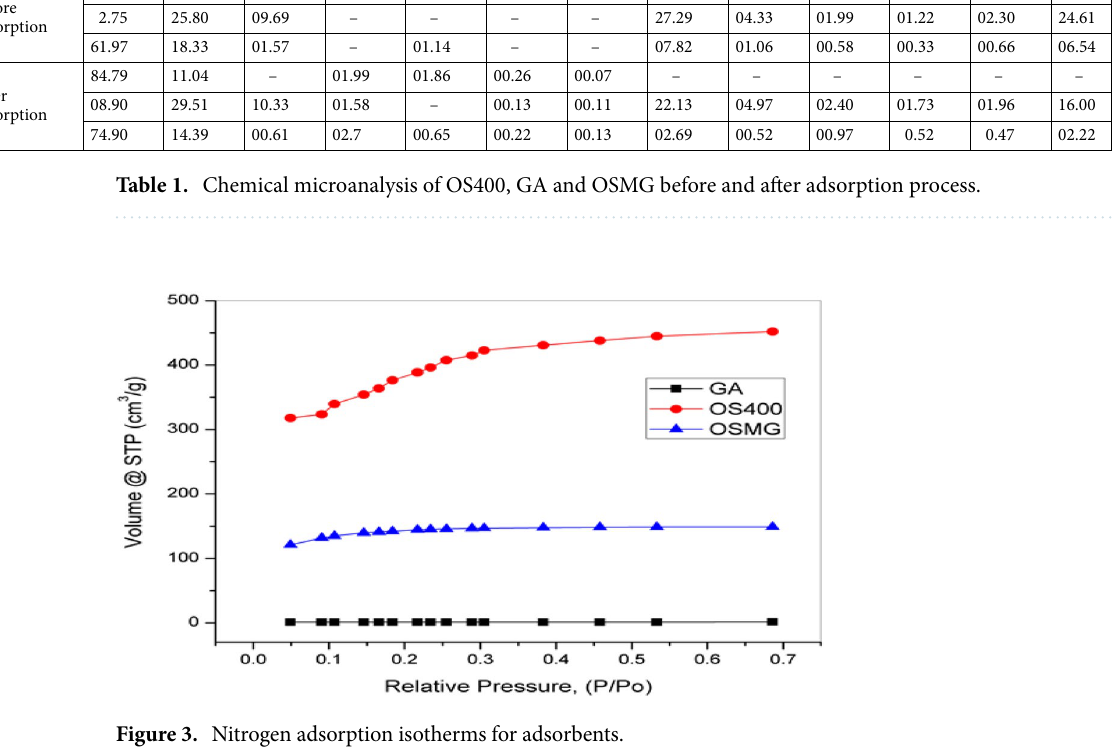
Figure 3. Nitrogen adsorption isotherms for adsorbents.